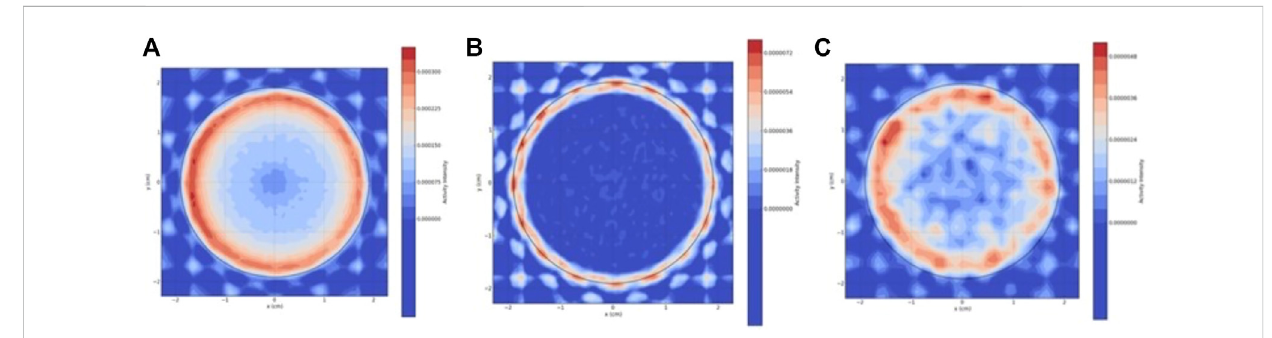
ForsampleBOT217, 137 Cs (A) , 60 Co (B) ,and 154 Eu (C) tomographicmaps.Theblackcircleisthecircumferenceofthesample.They-axistotherightis in counts, where the highest counts are in